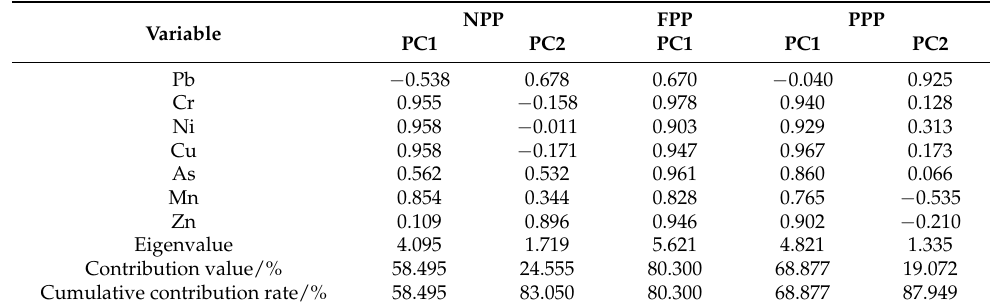
Table 3. Loading matrix of principal component analysis of heavy metals in the water of different subsidence